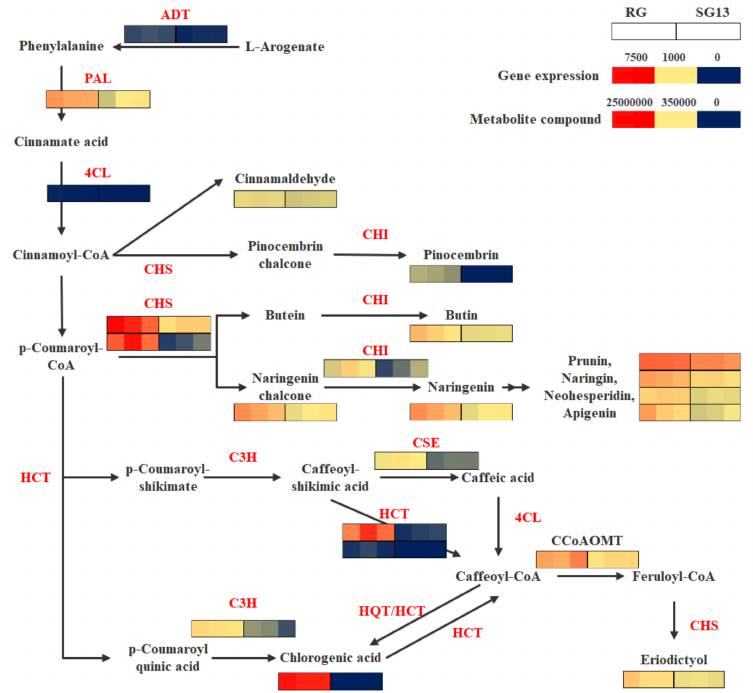
Figure 5. Phenylpropanoid and flavonoid biosynthesis upregulated in RG. This pathway is constructed based on the KEGG pathway. Each colored cell represents the normalized intensity of each compound according to the color scale (three biological replicates for each variety). Genes different expressed including prephenate dehydratase (ADT), phenylalanine ammonia-lyase (PAL), 4-coumarate-CoA ligase (4CL), 5-O-(4-coumaroyl)-D-quinate 3 (cid:48) -monooxygenase (C3H), caffeoylshiki- mate esterase (CSE), shikimate O-hydroxycinnamoyltransferase (HCT), caffeoyl-CoA O-methyltransferase (CCoAOMT), chalcone synthase (CHS) and chalcone isomerase